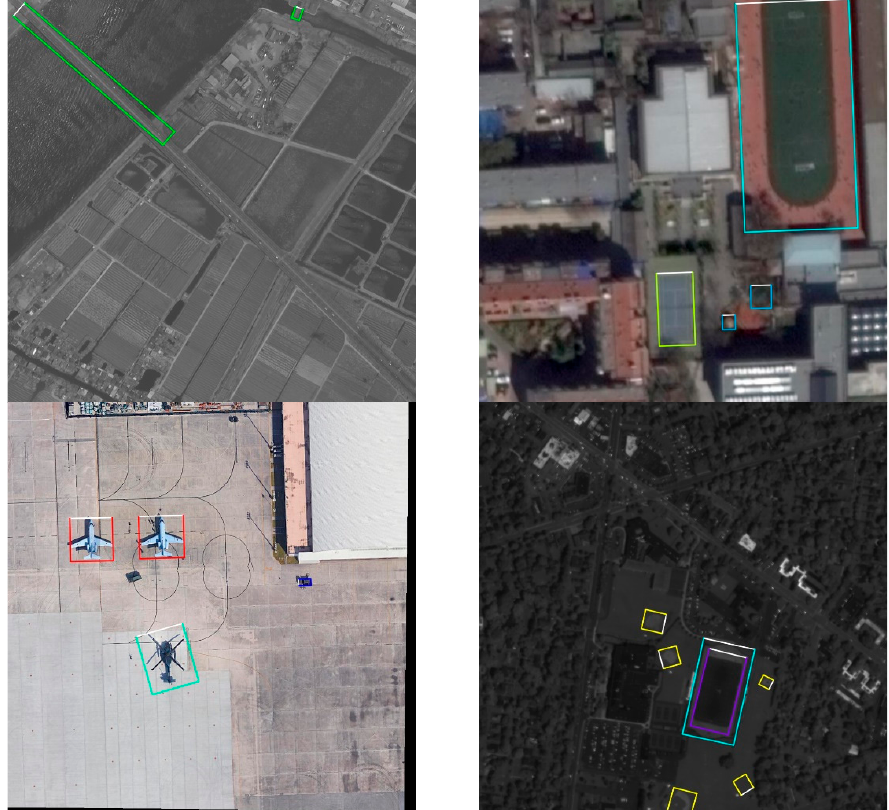
Figure 5. Detection results on DOTA1.0. The colors of OBBs are defined as follows: red: plane, yellow: baseball diamond, green: bridge, cyan: ground track field, blue: small vehicle, magenta: large vehicle, dark orange: ship, green yellow: tennis court, spring green: basketball court, deep sky blue: storage tank, dark violet: soccer ball field, deep pink: round about, orange: harbor, chartreuse: helicopter.